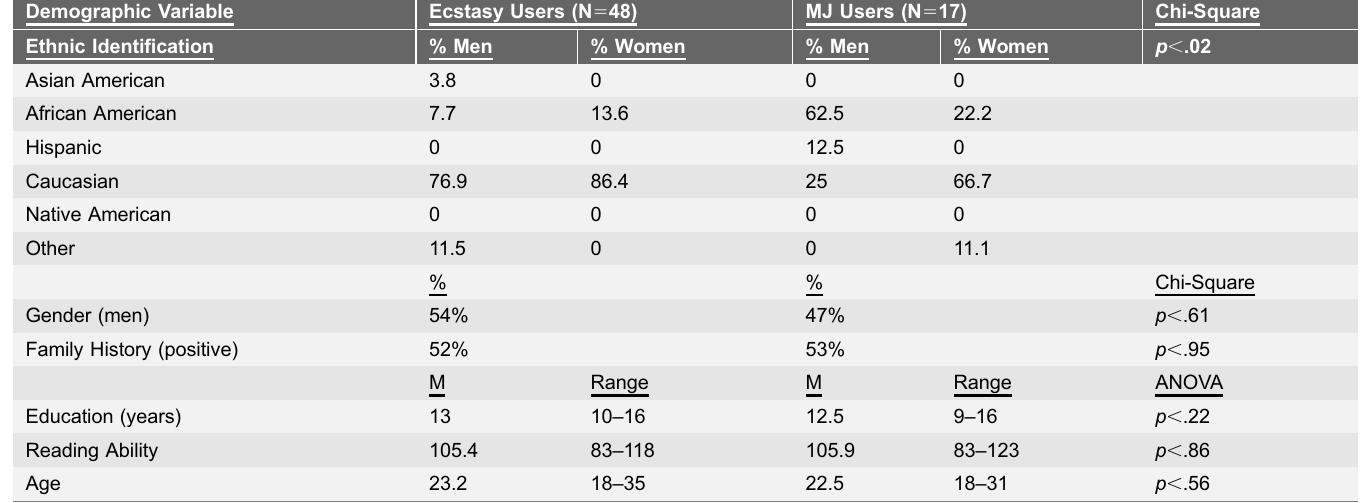
Table 1. Breakdown of Ethnic Identification, Education, Reading Ability, and Age of Ecstasy and MJ Users.